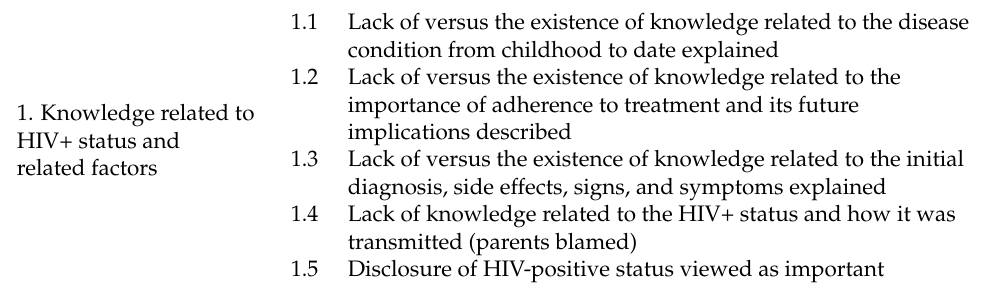
Table 2. Themes and sub-themes that emerged from the study